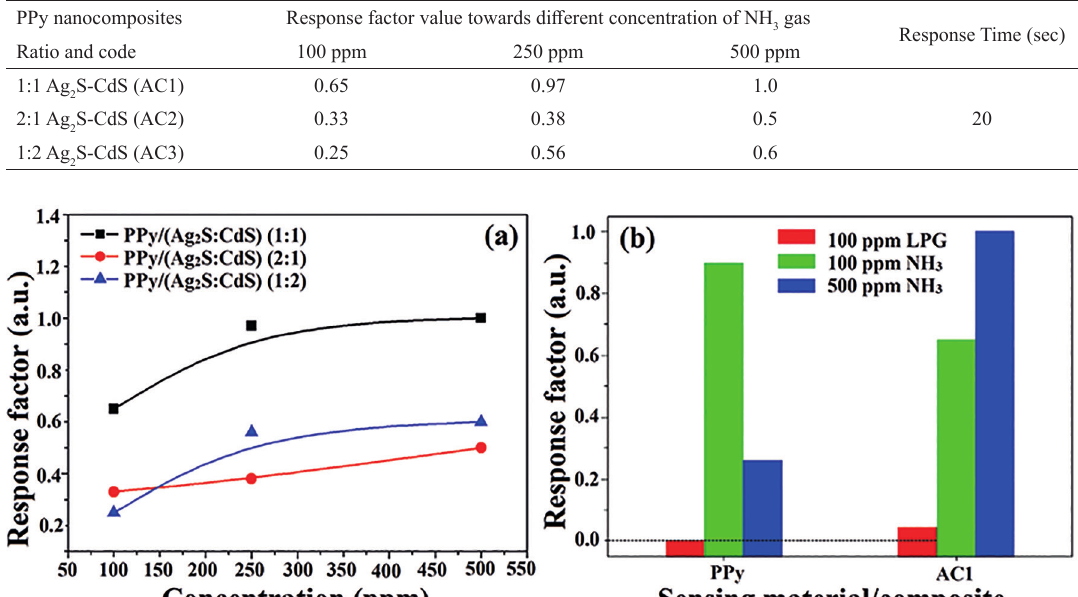
gas sensing; (b) Response 3